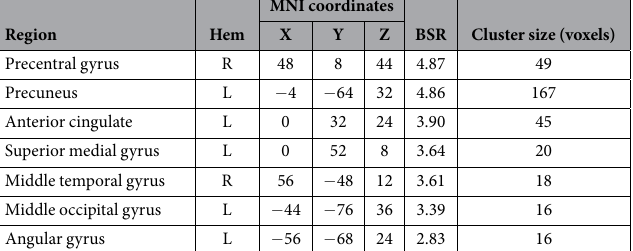
Table 1. Multivariate PLS model peak activations, bootstrap ratios, and cluster sizes for regions showing increased BOLD signal variability with age. Note: SD = standard deviation; BOLD = blood oxygen level- dependent; Hem = hemisphere; MNI = Montreal Neurological Institute; BSR = bootstrap ratio (model salience/ bootstrapped standard